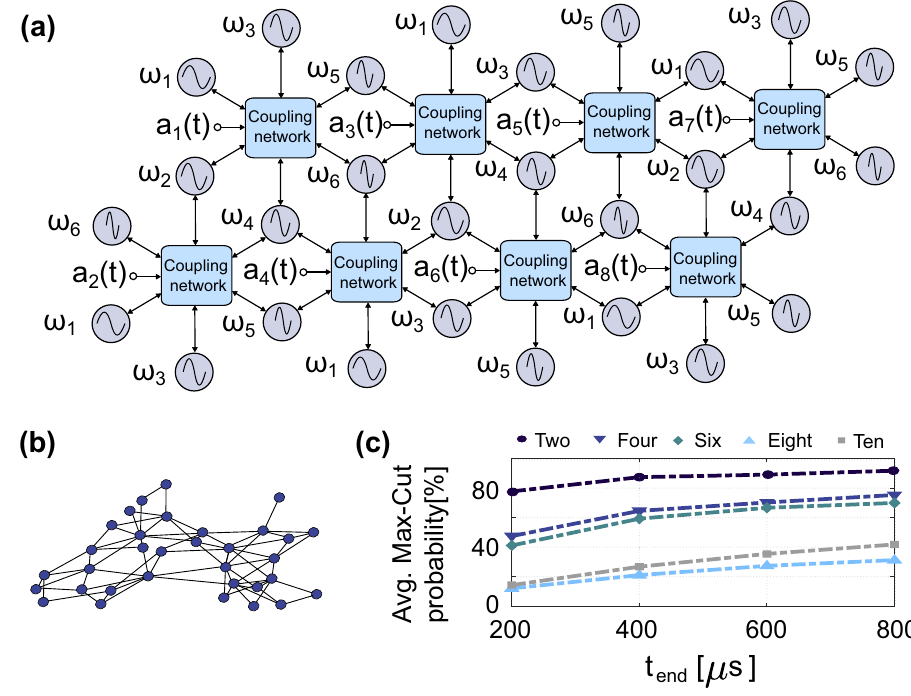
Figure 4. ( a ) Multiple hexagonal cells demonstrating a scalable implementation (note that the SHIL for each oscillator has been left out for clarity), ( b ) a randomly generated graph for ten cells and ( c ) average Max-Cut probability of randomly generated graphs for 2, 4, 6, 8 and 10